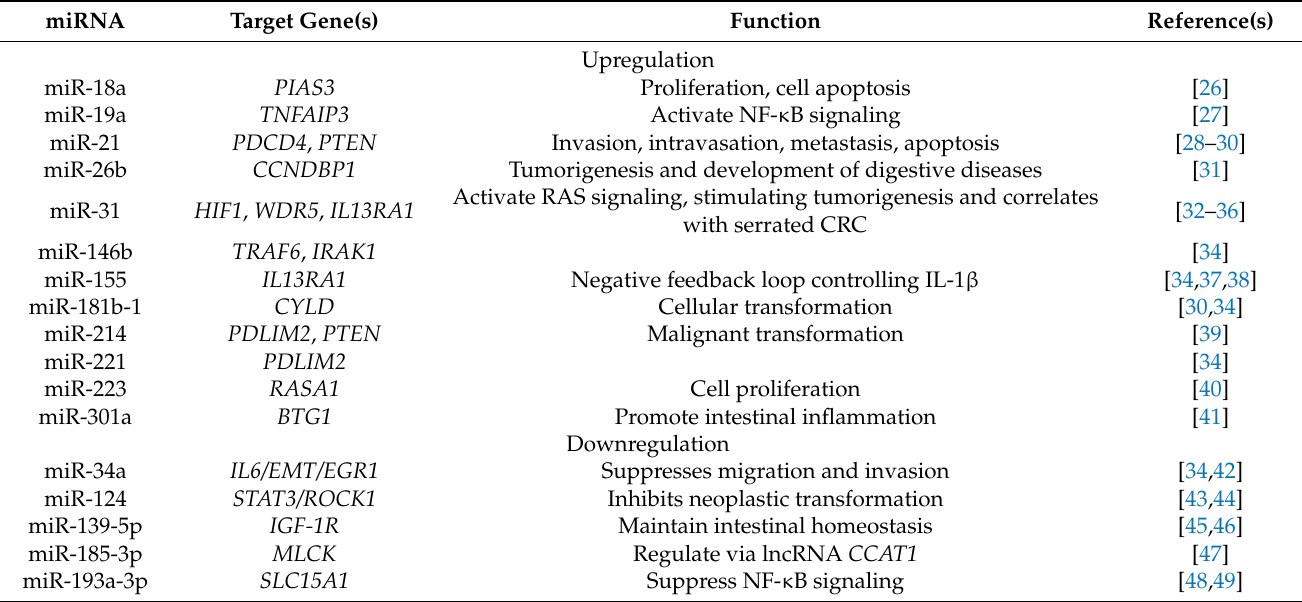
Table 2. Major microRNA studies in colitis-associated colorectal